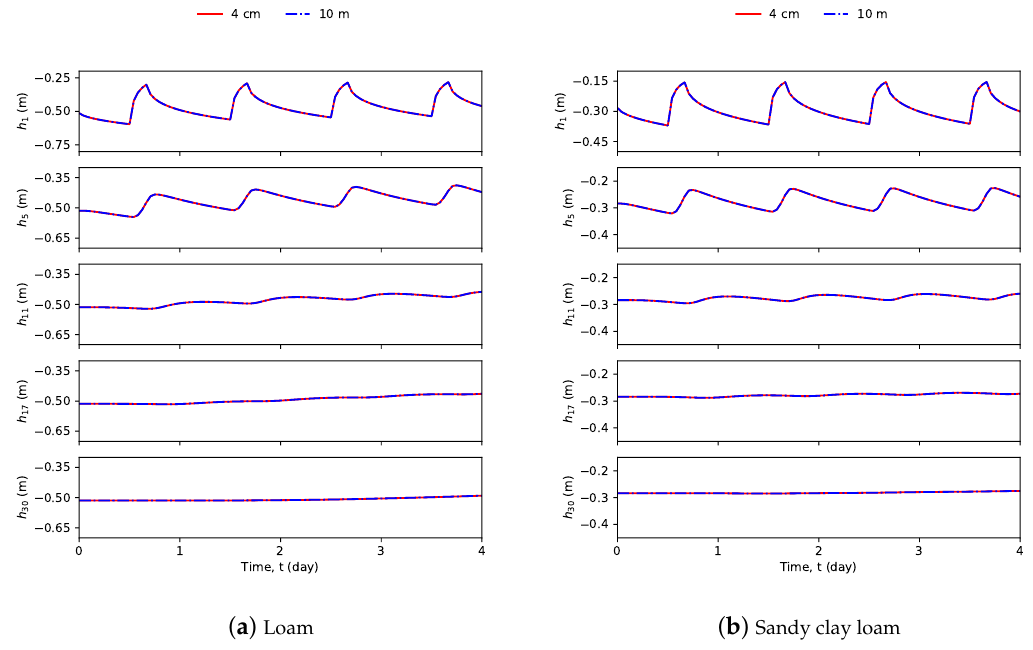
Figure A2. Comparison of selected trajectories of Model 1 (4 cm) and Model 2 (10 m) under Scenario